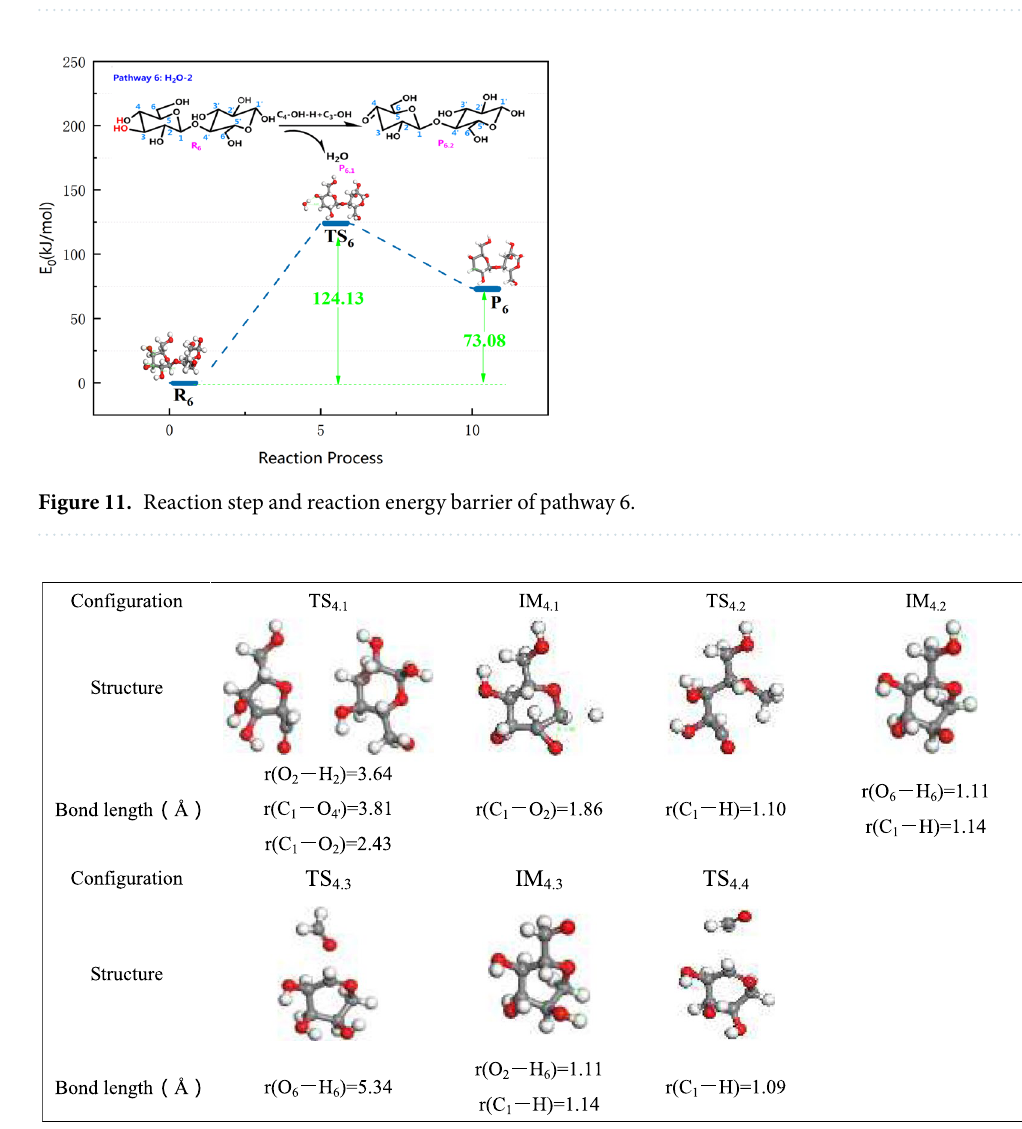
Figure 10. Reaction step and reaction energy barrier of pathway 5.